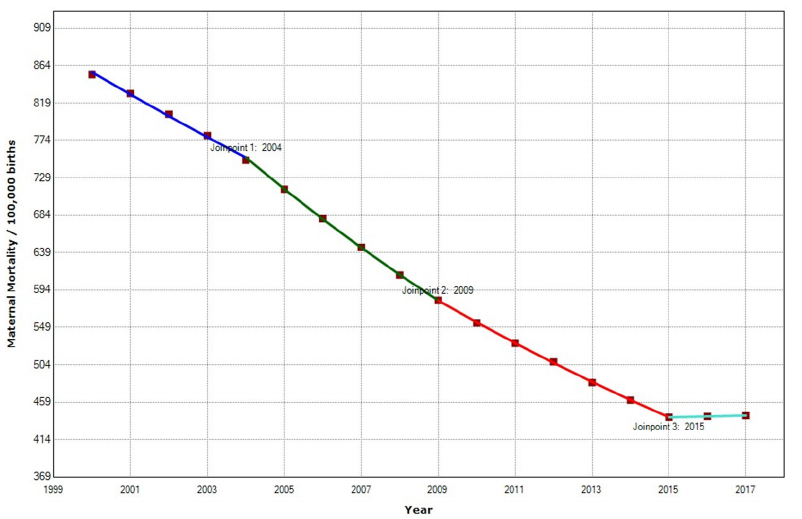
Figure 6. Maternal mortality trends in East Africa (2000–2017) indicate joinpoints at the transitions between colored lines. In the Central African region, during the period 2000–2017, maternal mortality decreased by 35.84%, from an MMR of 798.35 in 2000 to 512.19 in 2017. The APC during the whole period was − 2.7% per year (95% IC − 2.8; − 2.5). We detected three joinpoints in 2002, 2006, and 2011. Since 2006, the APC has been progressively decreasing, first to − 2.4% in 2006–2011 and later to − 2.0% in 2011–2014 (Figure 7).